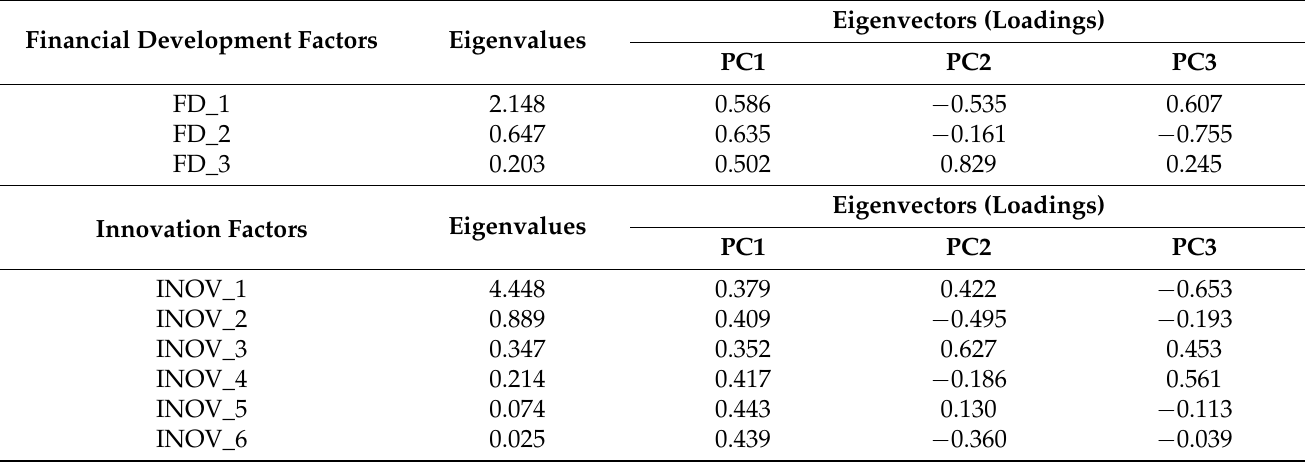
Table 3. Construction of FDINDEX and Innovation Index by Principal Components Analysis